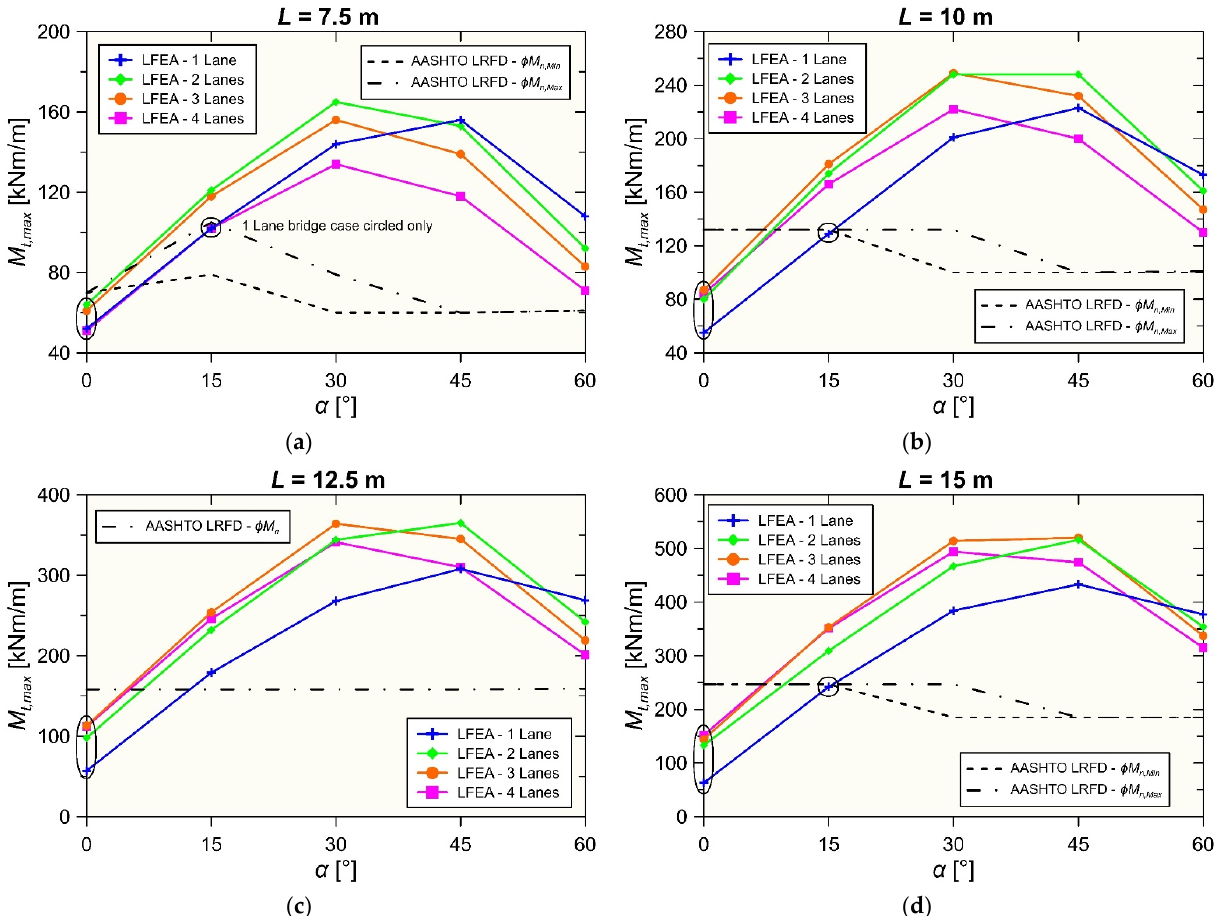
Figure 10. Comparison of LFEA maximum transverse bending moment and AASHTO LRFD bending moment capacity provided by distribution reinforcement. ( a ) L = 7.5 m, ( b ) L = 10 m, ( c ) L = 12.5 m, ( d ) L = 15 m. Circled data indicates that the same reinforcement was provided as for AASHTO LRFD.